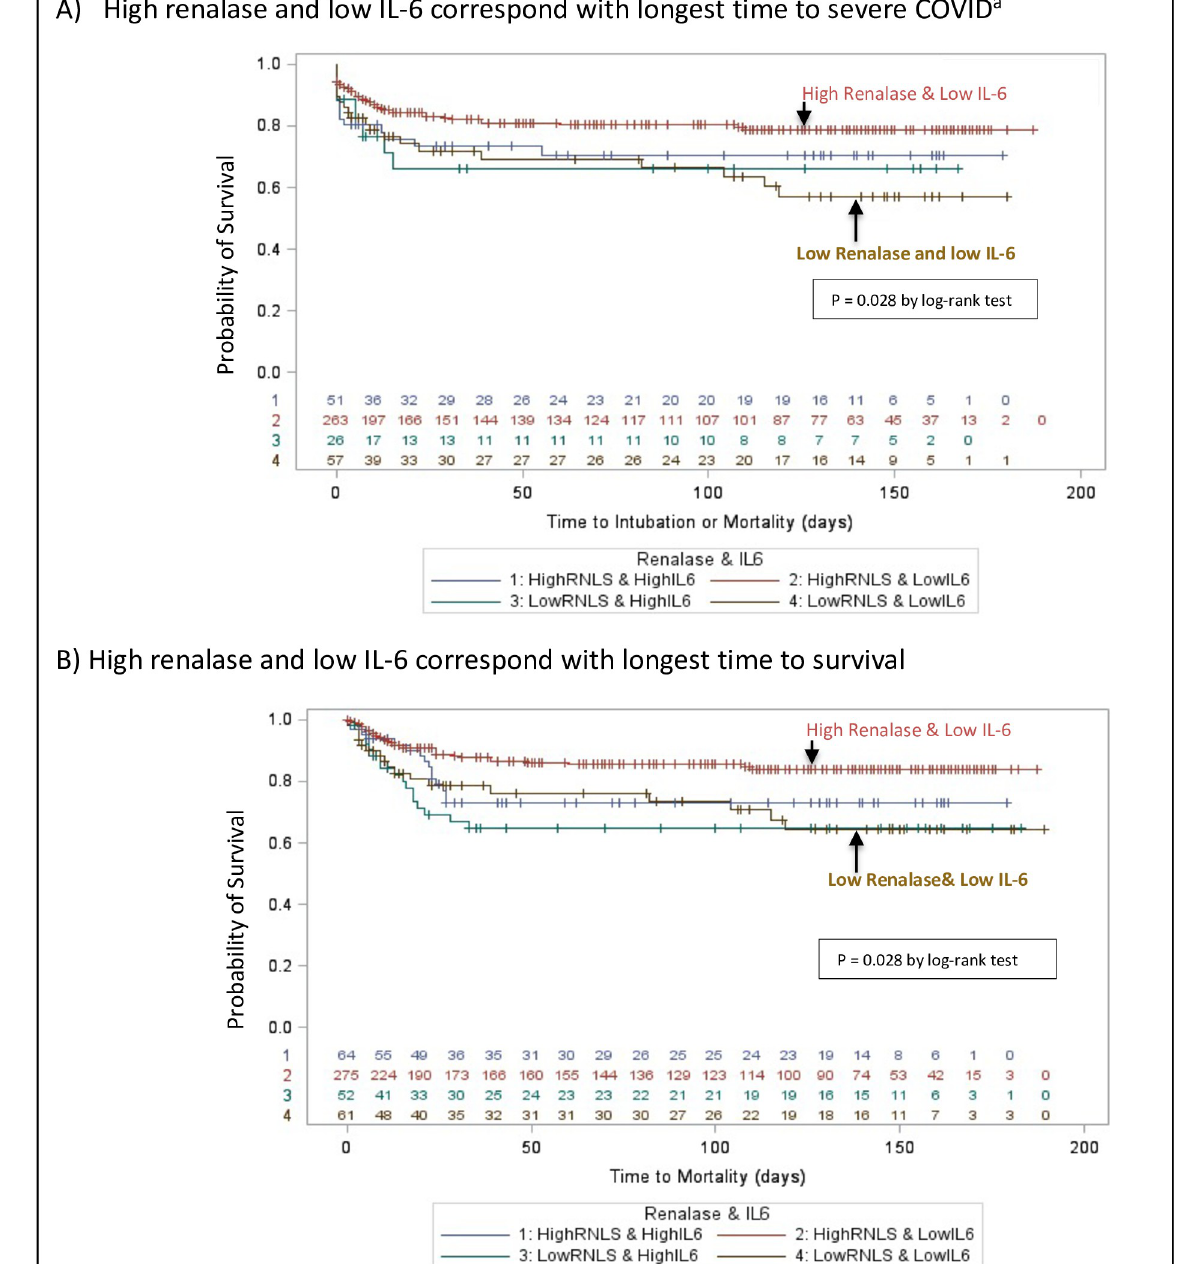
Fig 3. Time-adjusted survival curve for IL-6 and renalase among patients with COVID-19 disease (A) For composite outcome a : High renalase + High IL-6; High renalase + Low IL-6; Low renalase + High IL-6; Low renalase + Low IL-6 and (B) For Mortality: High renalase + High IL-6; High renalase + Low IL-6; Low renalase + High IL-6; Low renalase + Low IL-6. a For composite outcomes, patients with renalase samples drawn after intubution were excluded from survival analysis (n = 55).